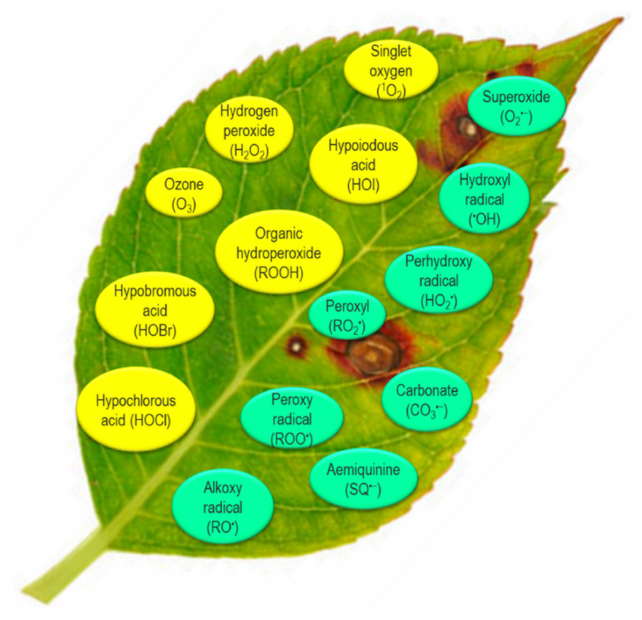
Figure 1. Types of reactive oxygen species (ROS) in plant cells.